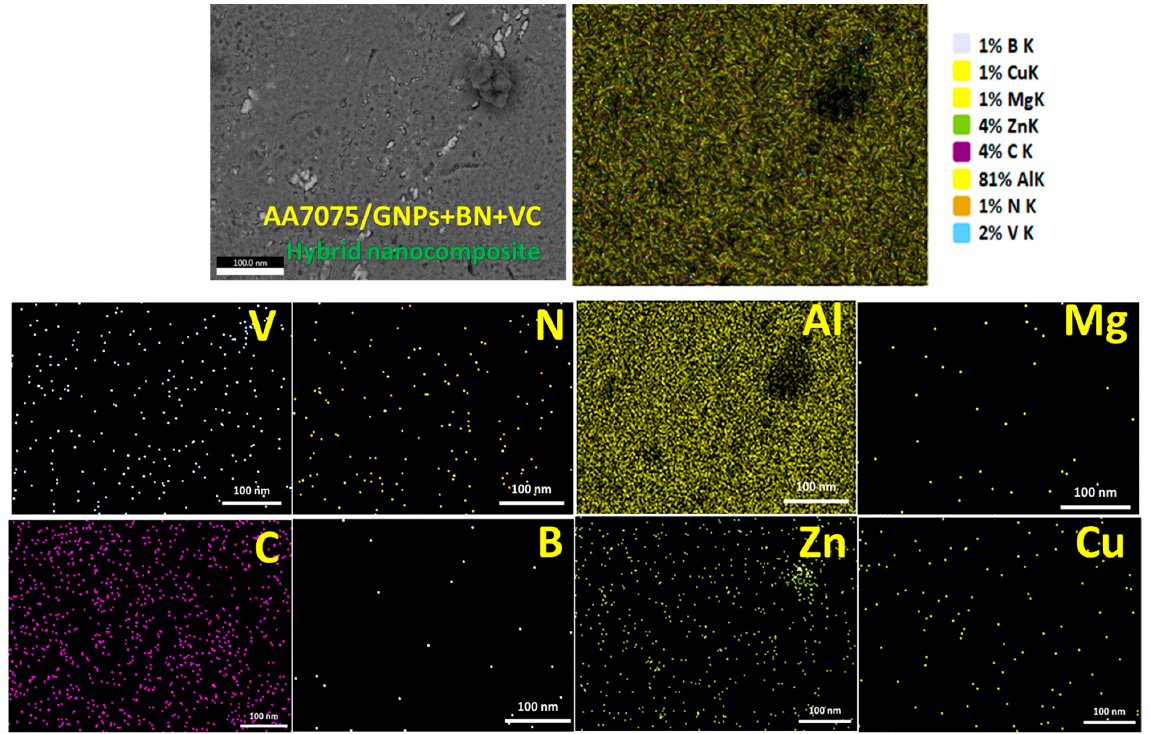
Figure 5. EDS mapping images of the hybrid composite AA7075/ GNP+BN+VC.